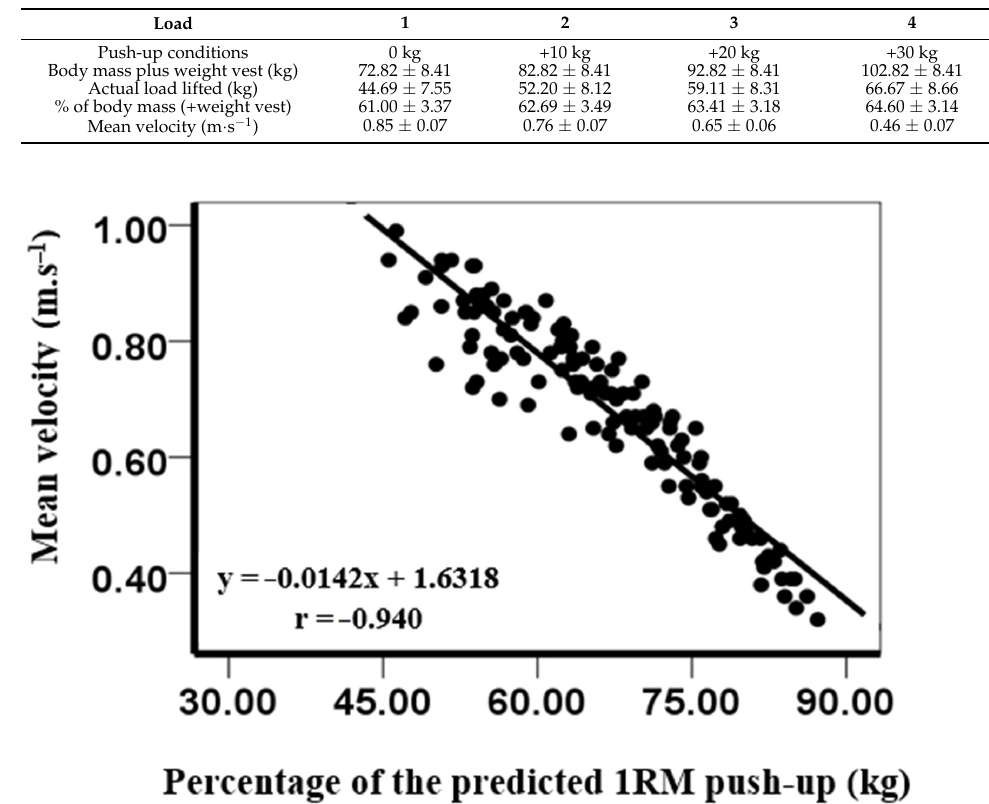
Figure 2. Relationship between mean velocity at each load and the percentage of the 1RM push-up. The results of the present study revealed a significant nearly perfect correlation between the calculated predicted 1RM push-up and the 25 (r = − 0.96) and 50 m front crawl (r = − 0.97). Our results also indicated a significant nearly perfect correlation between the 1RM push-up and 25 (r = − 0.94) and 50 m (r = − 0.96) front crawl with arms only (Figure 3).